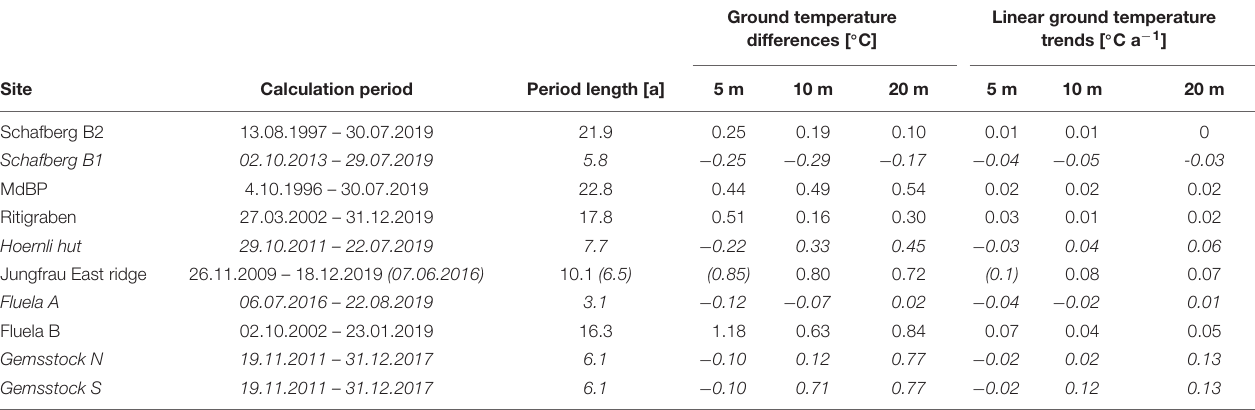
TABLE 2 | Ground temperature differences calculated from linear trends of 365-day running means of ground temperatures in varying depths between the start and end of the temperature series of each borehole. Annual ground temperature trends [ ◦ C a − 1 ] are also shown. Muot da Barba Peider B1 is abbreviated as MdBP. At Jungfrau East ridge the analysed data time series at 5 m depth (values in brackets and italic) is shorter than at 10 and 20 m depth due to sensor failure. Results from time series shorter than 10 years are written in italics. See Figure 6 for